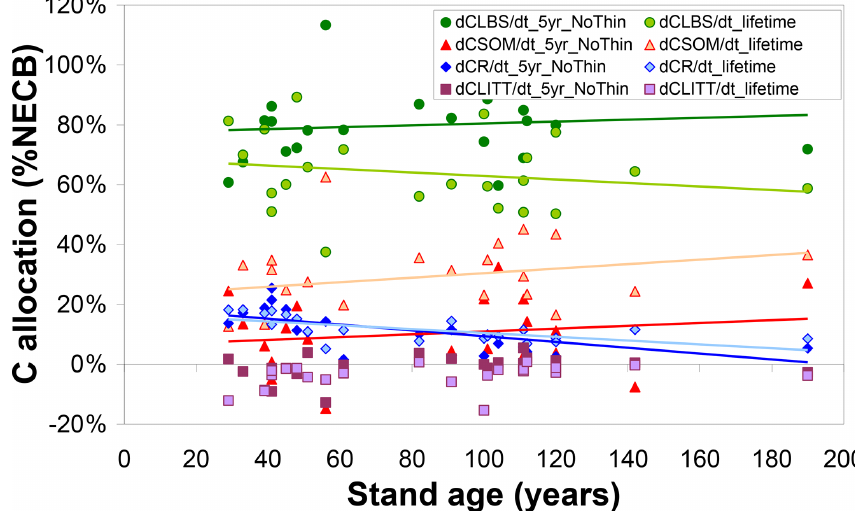
Figure 5. Modelled (BASFOR) ultimate allocation of sequestered C (expressed as % net ecosystem carbon balance NECB) into ecosystem pools in soil organic matter (CSOM); roots (CR); litter layers (CLITT); and leaves, branches and stems (CLBS). Each data point represents 1 of 22 modelled forest sites, plotted as a function of stand age. At each site, the net ecosystem carbon balance equals the sum of all individual storage (or loss) terms, i.e. NECB = dCLBS / d t + dCSOM / d t + dCR / d t + dCLITT / d t , shown here as fractions of the total to indicate the relative importance of the different ecosystem sinks. Values are calculated either (i) over the most recent 5-year period including no thinning event around the time frame of the CEIP–NEU integrated projects or (ii) over the whole lifetime of the stands (including all thinning